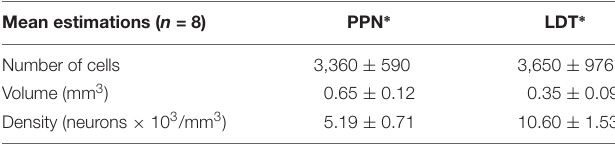
TABLE 2 | Estimated number, volume, and density of cholinergic cells in the PPN and